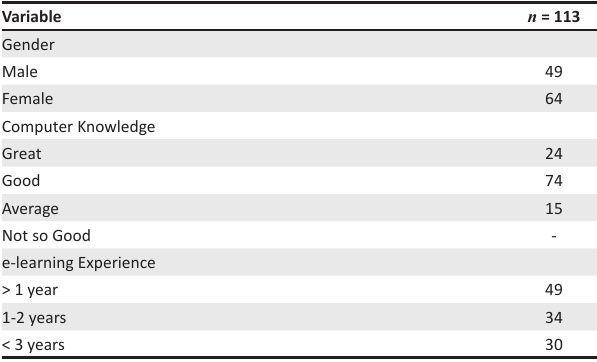
TABLE 2: Biographical characteristics.